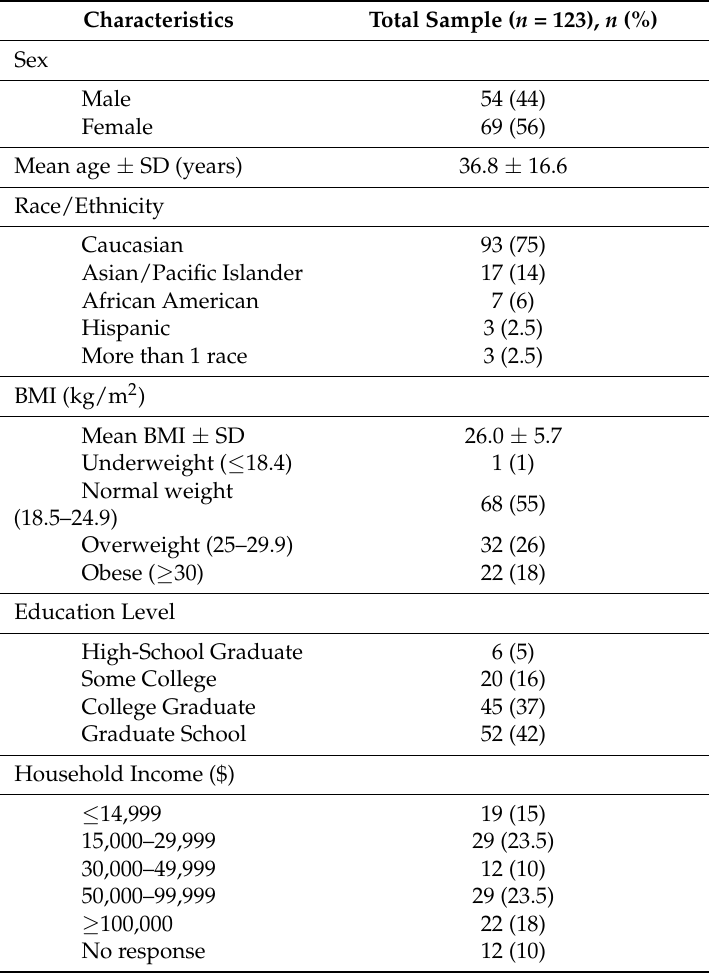
Table 1. Participant demographic characteristics.